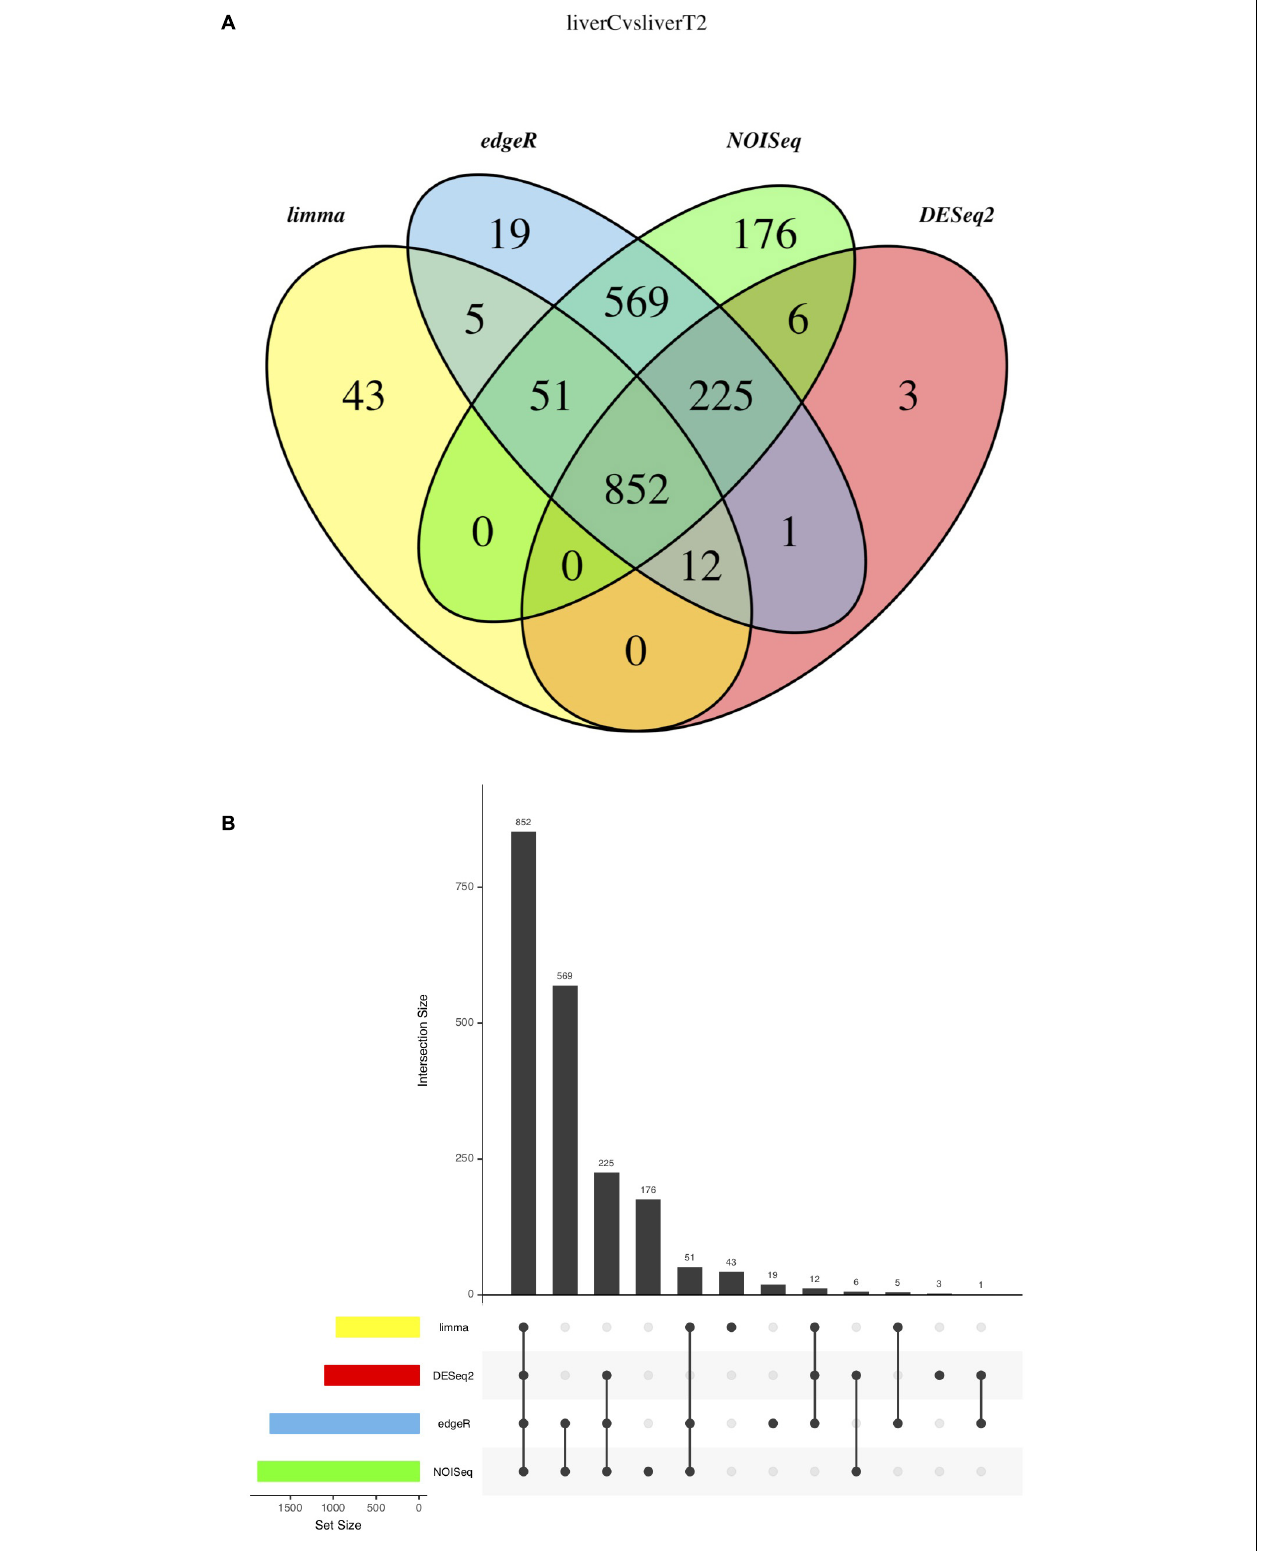
FIGURE 8 | Result Integration summary. (A) Venn diagram representing the result intersection for each selected method. (B) Upset plot representing the contribution of each selected method.